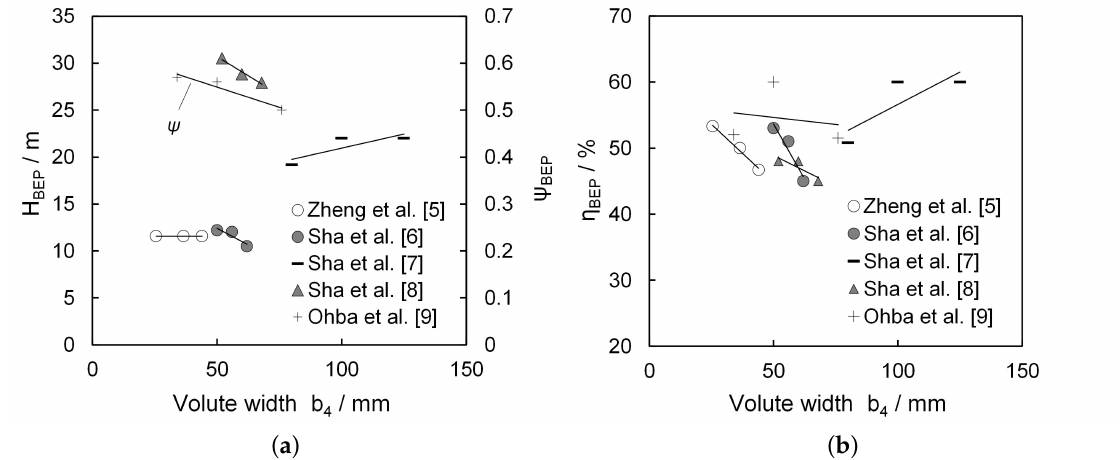
Figure 16. ( a ) Head and pressure coefficient over volute width; and ( b ) efficiency over volute